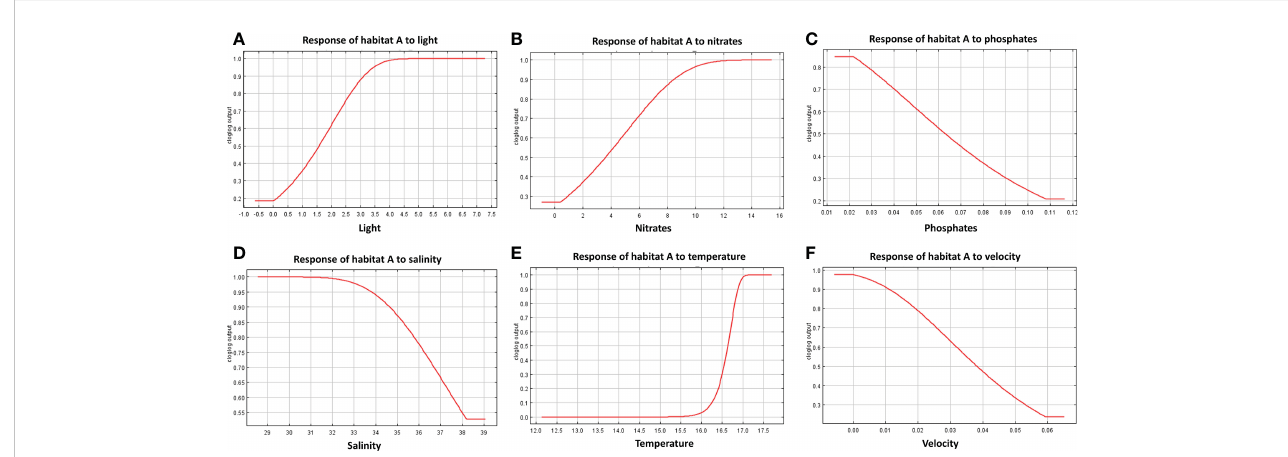
FIGURE 7 Response curves derived from MaxEnt reporting the relationship of predicted suitability of habitat A to environmental variables, with y-axis indicating the probability values and x-axis the concentration/intensity of the variables: (A) relationship between habitat A and light; (B) relationship between habitat A and nitrate concentration; (C) relationship between habitat A and phosphate; (D) relationship between habitat A and salinity; (E) relationship between habitat A and temperature; (F) relationship between habitat A and velocity.